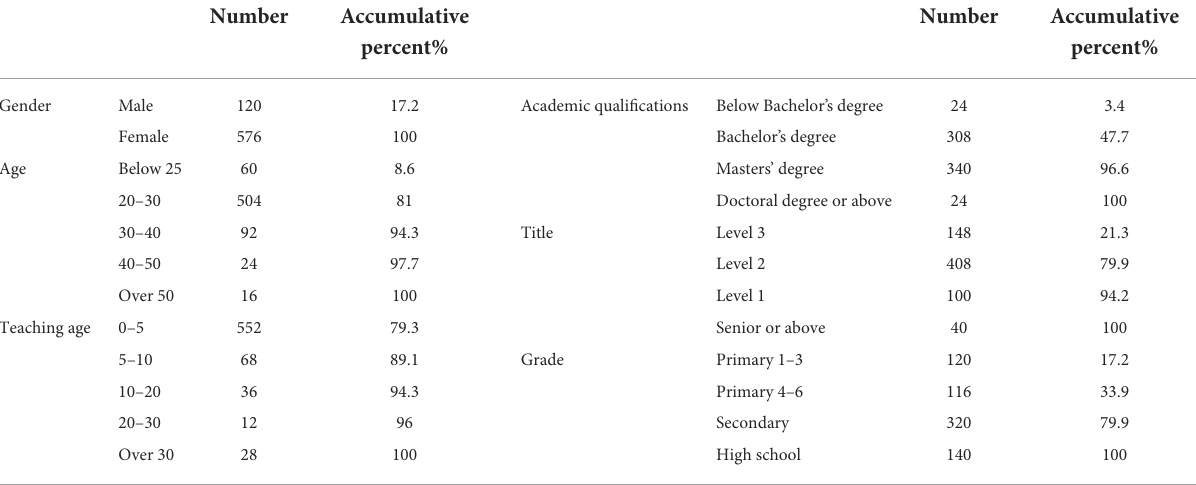
TABLE 4 Demographic statistics of the participants in TDL-TPACK applying.